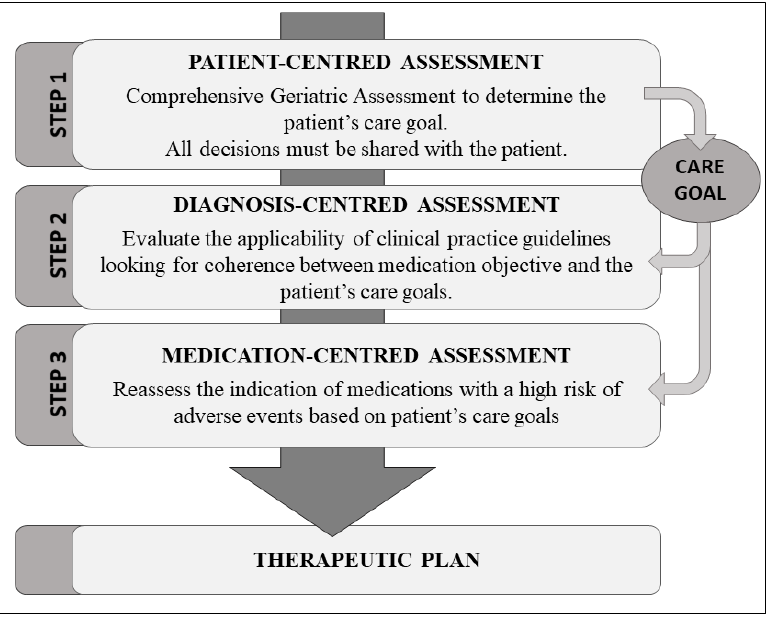
Figure 2. Patient-centered prescription (PCP)